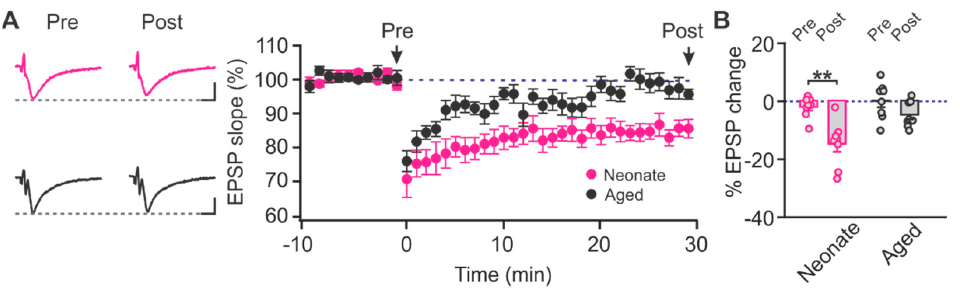
Figure 6. The role of ryanodine receptor in age-dependent LTD in the piriform layer Ib. ( A ) Example traces and time courses of fEPSPs with LTD inductions in the presence of dantrolene (50 µM) in neonate and aged rats. Scale bars, 0.5 mV, 5 msec. ( B ) % changes of fEPSPs at 30 min post-LTD induction. Neonate: n = 8; Aged: n = 8. ** p < 0.01.